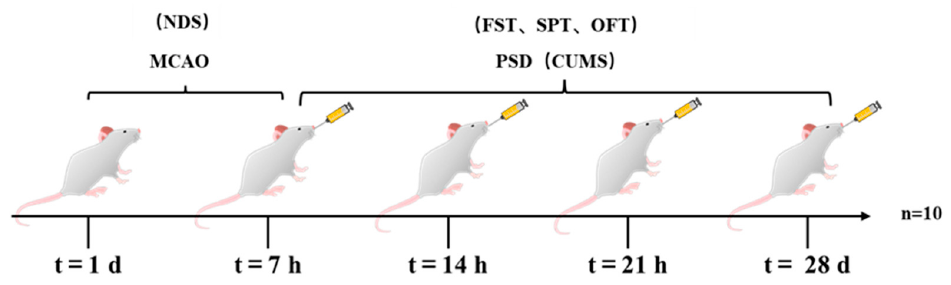
Figure 6. Drug administration in